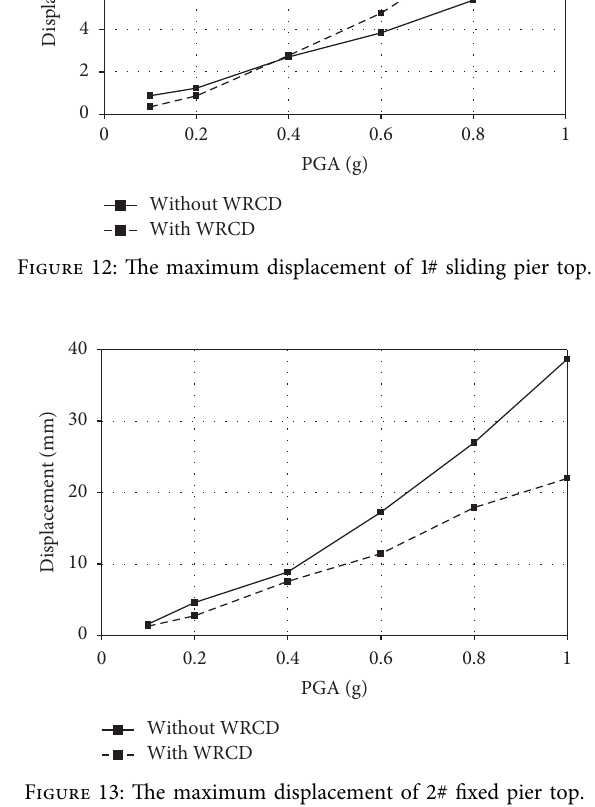
Figure 16: Maximum strain response at 1# sliding pier